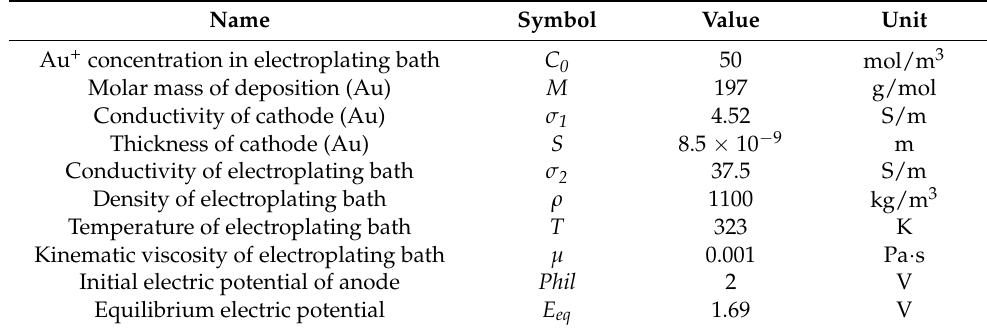
Table 2. Flow field simulation parameters of electroplating Au